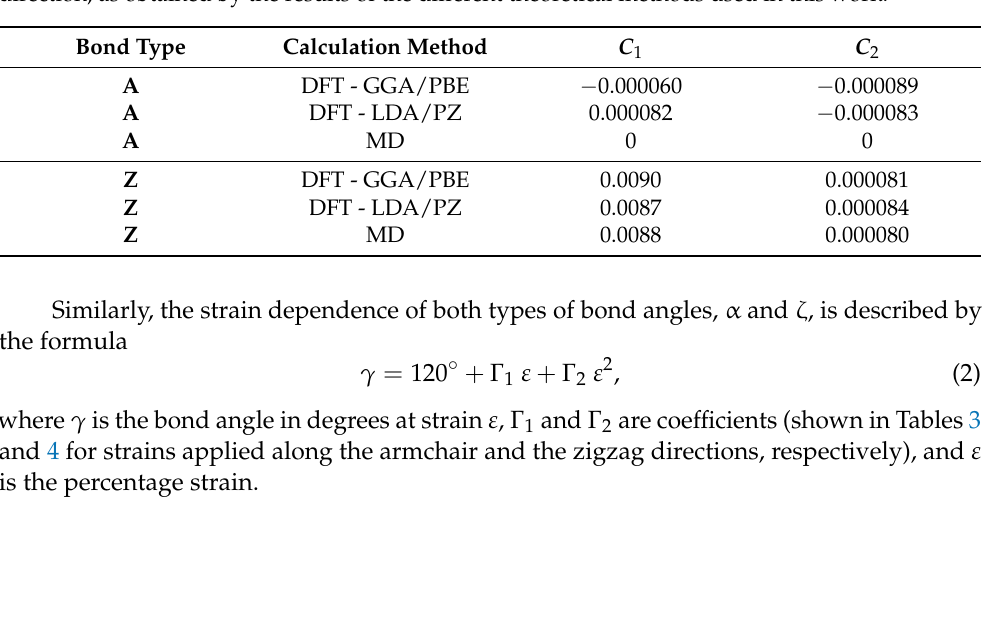
Table 2. Coefficients C 1 [in Å/(%strain)] and C 2 [in Å/(%strain) 2 ] of the strain dependence of the lengths [see Equation (1)] for the bond types A and Z, when the strain is applied along the zigzag direction, as obtained by the results of the different theoretical methods used in this